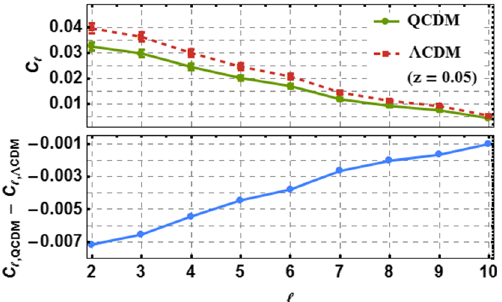
Fig. 4 Top: luminosity distance power spectrum C (cid:11) at z = 0 . 01 with integration ranging from k = 10 − 4 to 0 . 1 Mpc − 1 h for each (cid:11) = 2 to 10. Bottom: residue of the luminosity distance power spectrum between QCDM and (cid:4) CDM